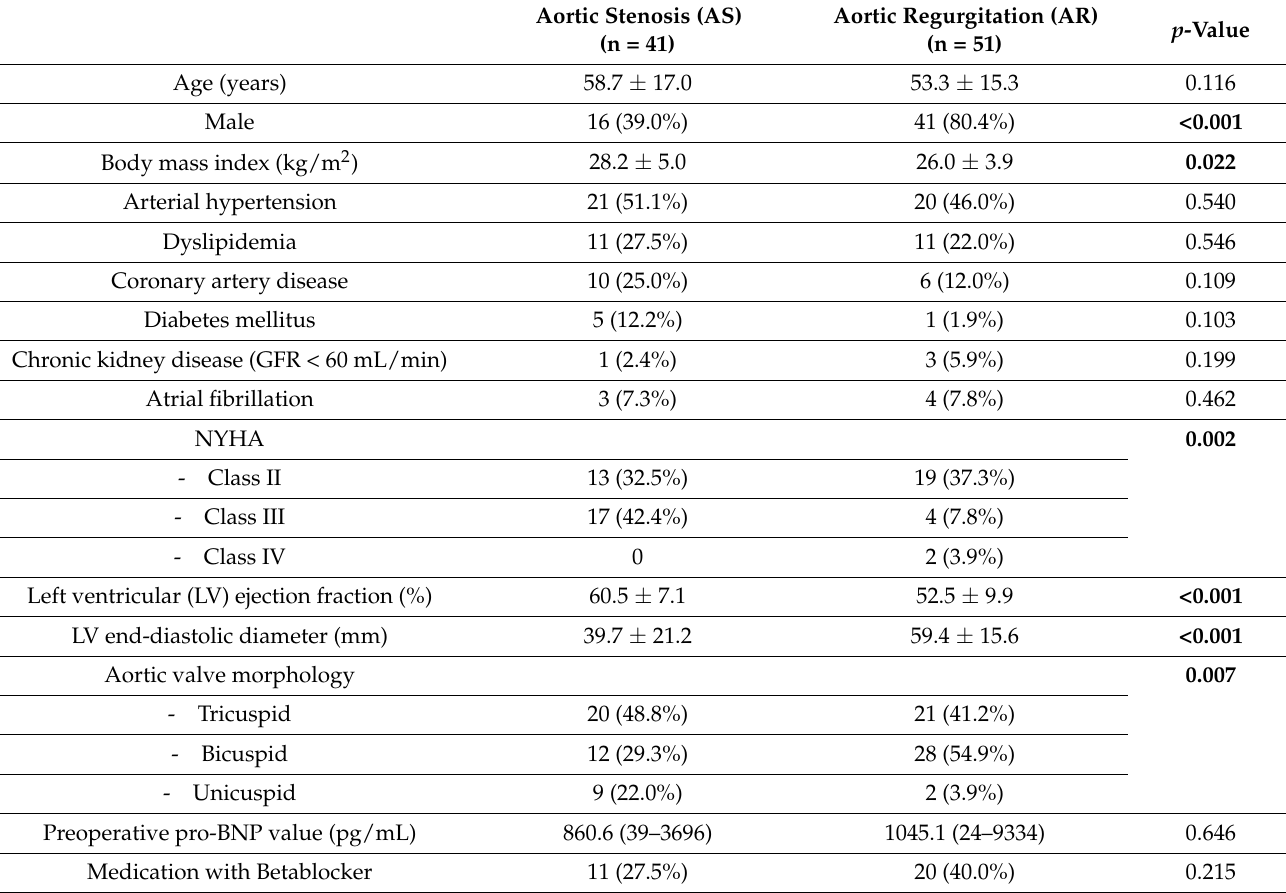
Table 1. Patient characteristics of patients with aortic stenosis (n = 41) and regurgitation (n = 51). Aortic Stenosis (AS) Aortic Regurgitation (n = 41)